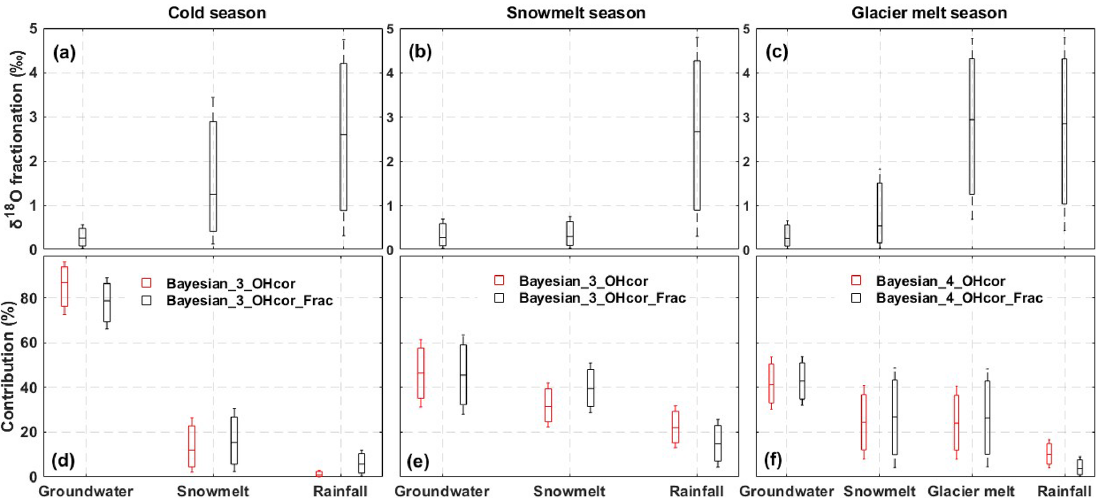
Figure 9. Effects of isotope fractionation on the estimates of CRCs in the Bayesian approach for the three seasons. (a–c) Estimated changes in δ 18 O of runoff components caused by the fractionation effect; (d–e) CRCs estimated by the Bayesian_3_OHcor and the Bayesian_3_OHcor_Frac; and (f) CRCs estimated by the Bayesian_4_OHcor and the Bayesian_4_OHcor_Frac.